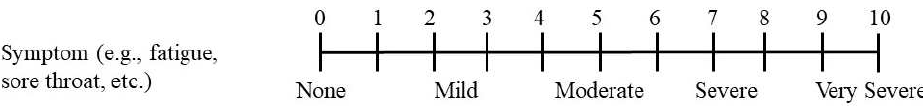
Figure 1. Visual Analogue/Likert Scores of